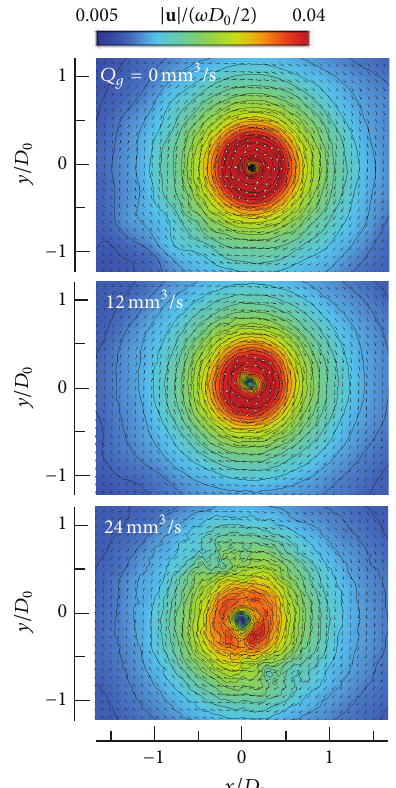
Figure 13: Change in water velocity due to bubbles at 𝑧/𝐷 0 = 4.17 when Ω = 11.7 × 10 4 .